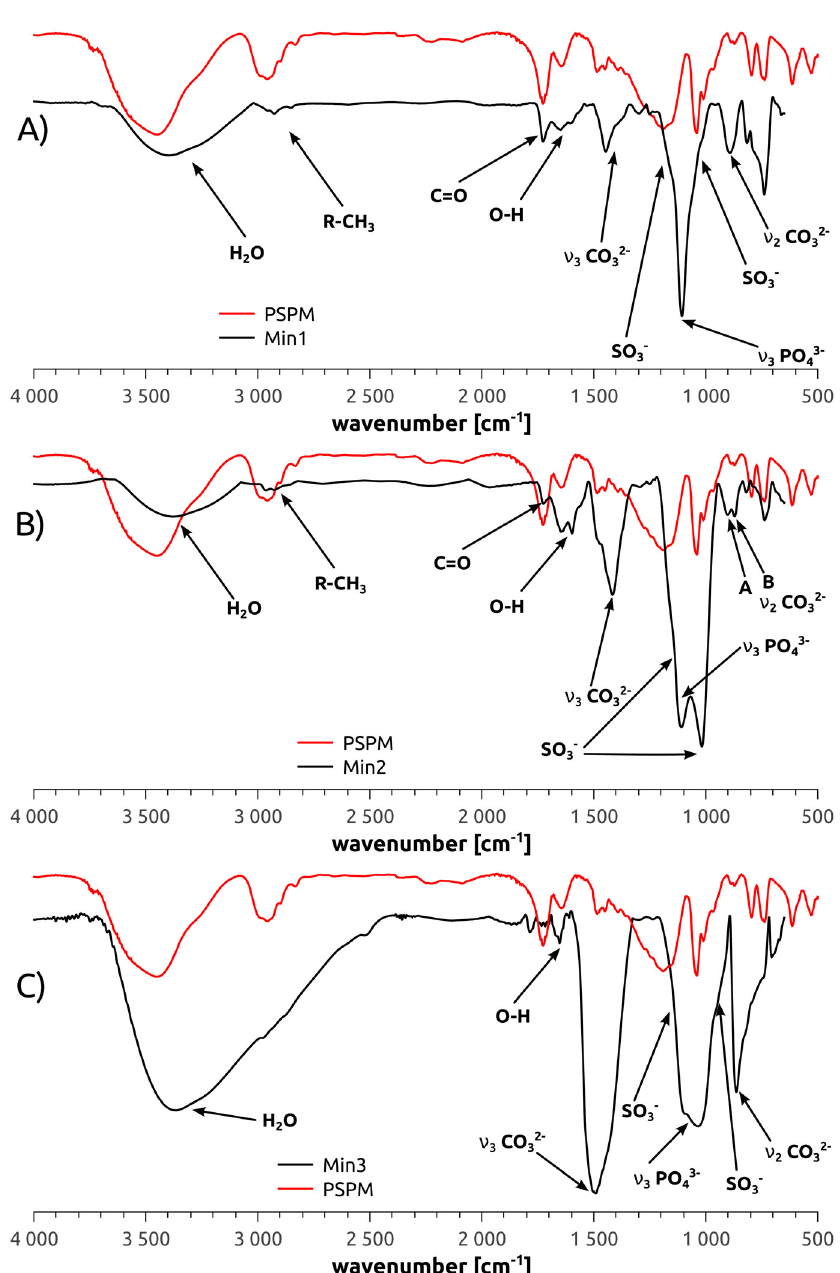
Figure 6. IRRAS data of the mineralized polymer brushes. ( A ) Min1; ( B ) Min2 and ( C ) Min3. PSPM refers to the neat polymer (i.e., polymer not attached to the surface, reproduced from [15] with permission, copyright American Chemical Society, 2014).